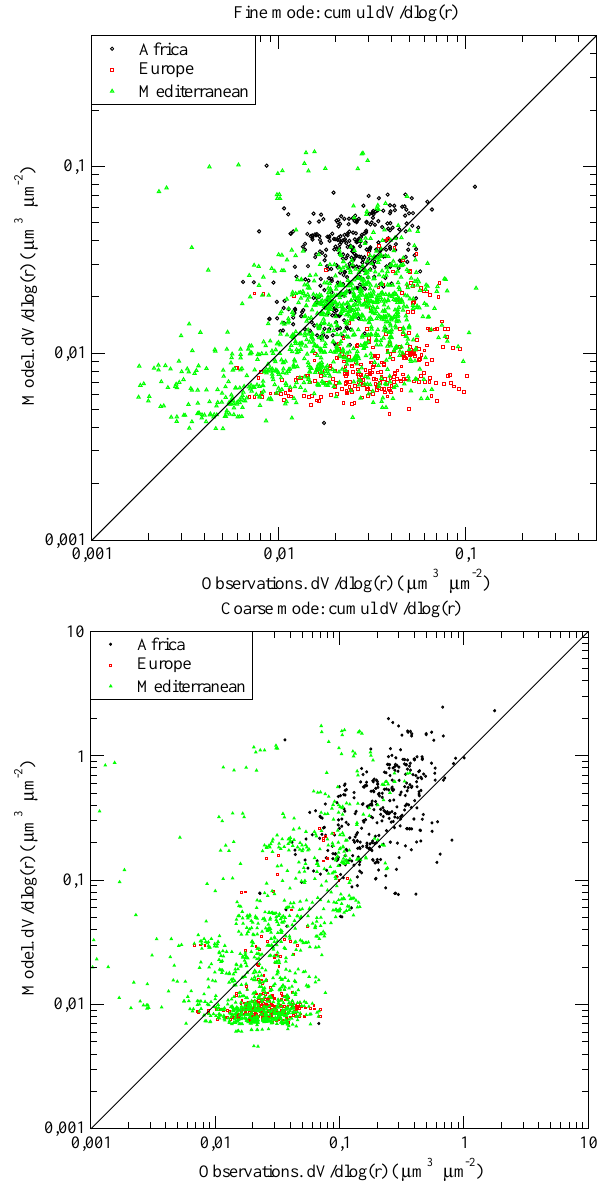
Figure 12. Scatter plots for comparisons between the observations and the model for the aerosol size distribution. Each plot corre- sponds to the sum of the concentrations of aerosol for the “fine” mode ( r < 0 . 5µm) and the “coarse” mode ( r > 0 . 5µm). Each point corresponds to an hour during the whole simulation and a modeled concentration corresponding to an AERONET site. The sites are split in three families: Africa (black symbols), Europe (red symbols) and Mediterranean region (green symbols), following the classifica- tion explained in Table